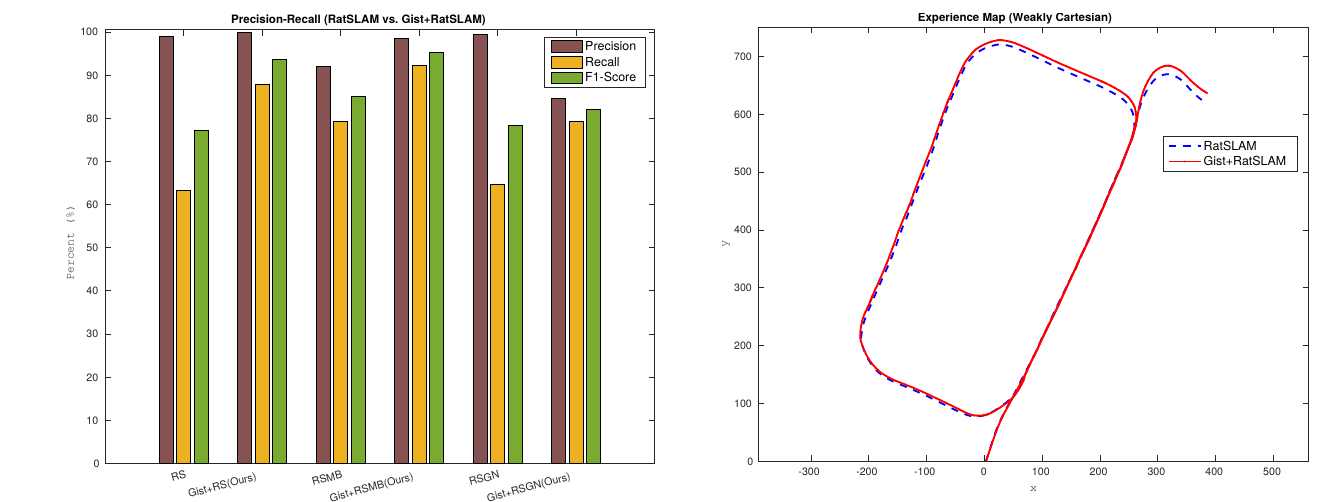
Figure 7: Precision-recall rate for different scenar- ios: RatSLAM shows 99.39% precision for the ad- ditive Gaussian noise case (RSGN). But it has only 64.8% recall-rate compared to our Gist+RSGN in- dicating 79.4% recall; interpreting results with F1 metric shows robustness of our method for all cases.